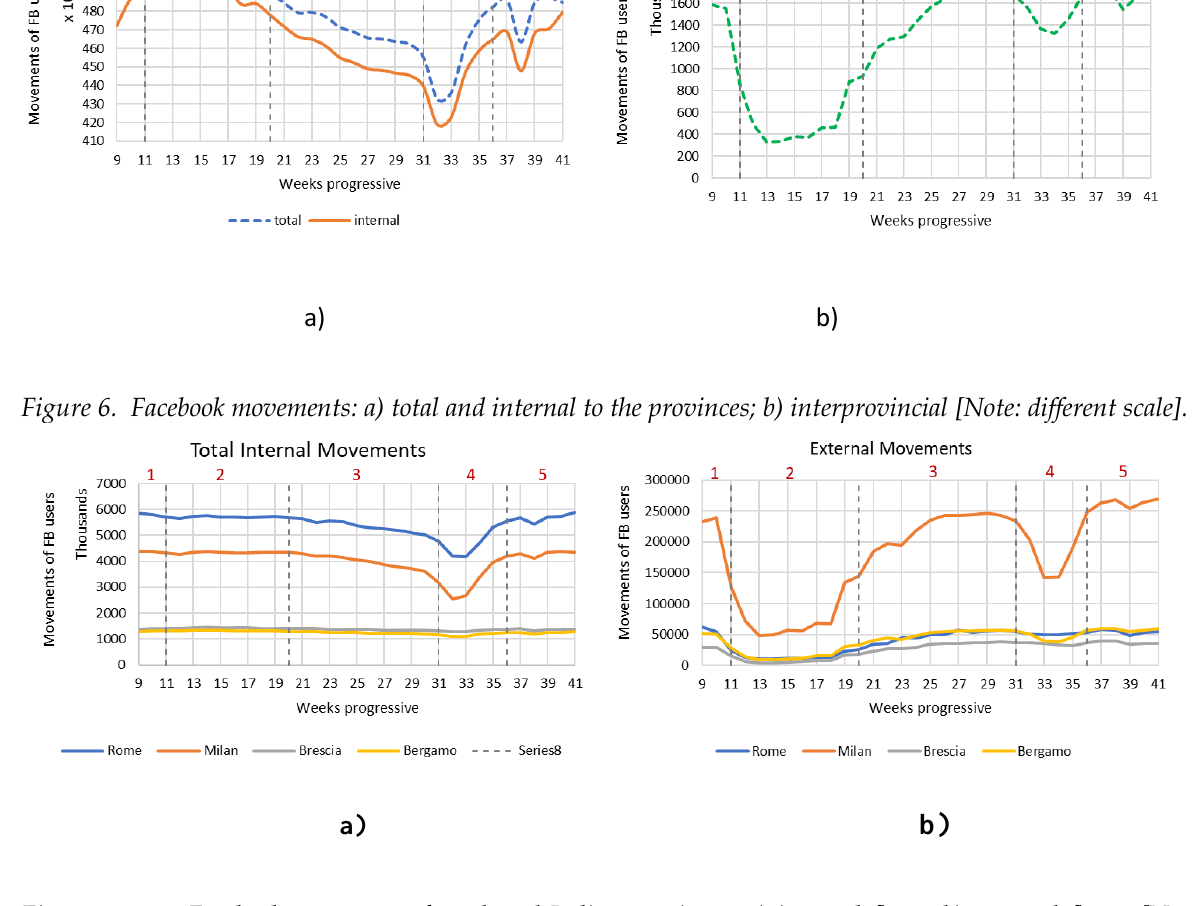
Figure 7. Facebook movements for selected Italian provinces: a) internal flows; b) external flows. [Note: different